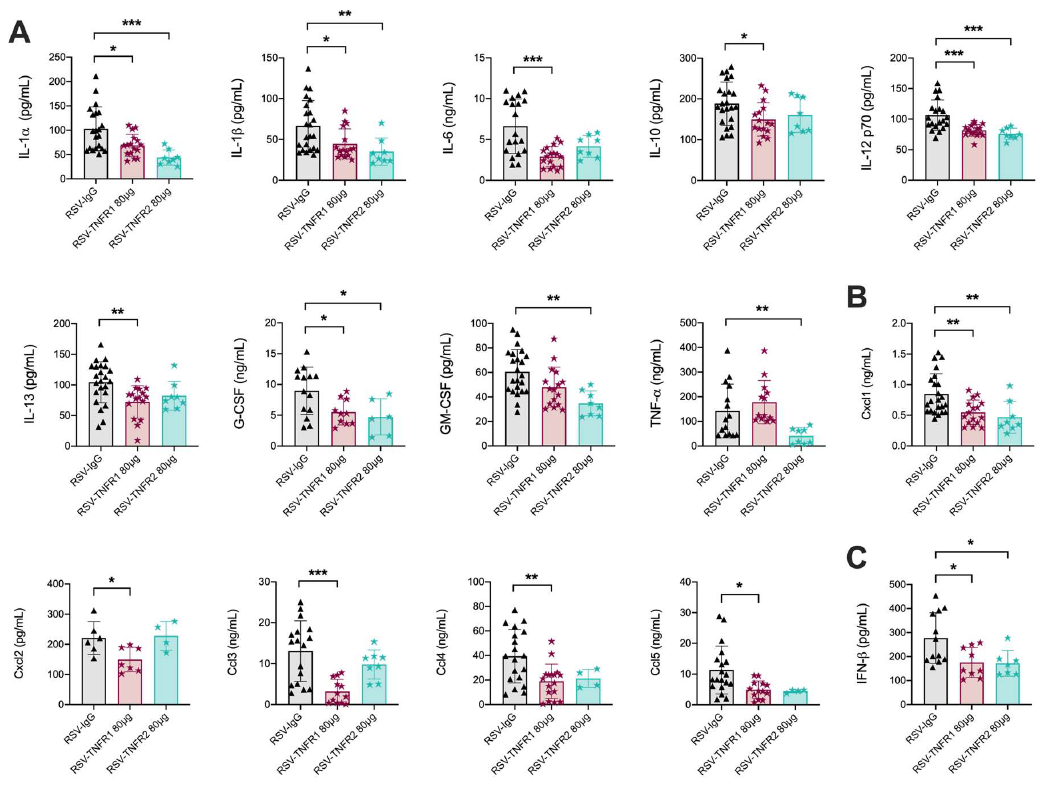
Figure 4. Blockade of TNFR1 or TNFR2 reduces pro-inflammatory cytokines and chemokines at day one post-infection. BALF was collected and analyzed for ( A ) cytokines and ( B ) chemokines by Bio-plex as well as ( C ) IFN- β by ELISA. Data for RSV-TNFR1 are pooled from five independent experiments. Data for RSV-TNFR2 are pooled from two independent experiments. Data are expressed as mean ± SD. Significant results as compared to the respective control are marked with asterisks (* for p ≤ 0.05, ** p ≤ 0.01, *** p ≤